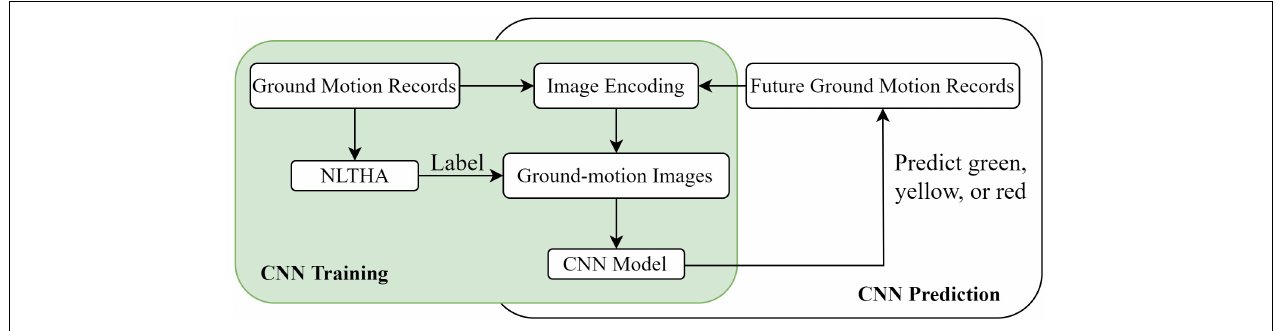
FIGURE 1 | Methodology of the convolutional neural networks- (CNN) based seismic damage evaluation.